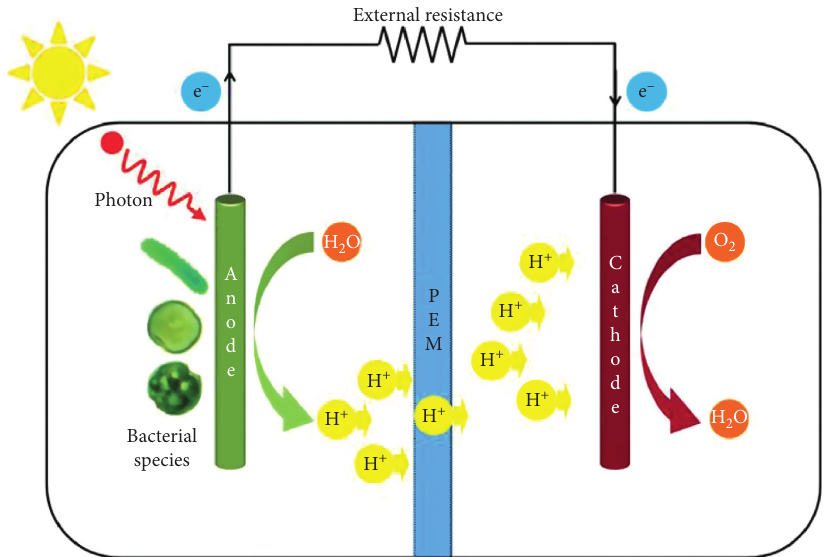
Figure 2: A dual-chamber PMFC with photosynthetic microorganisms serving as electricigens in the anodic chamber is shown sche- matically (adapted from [129] with Springer Nature Open Access